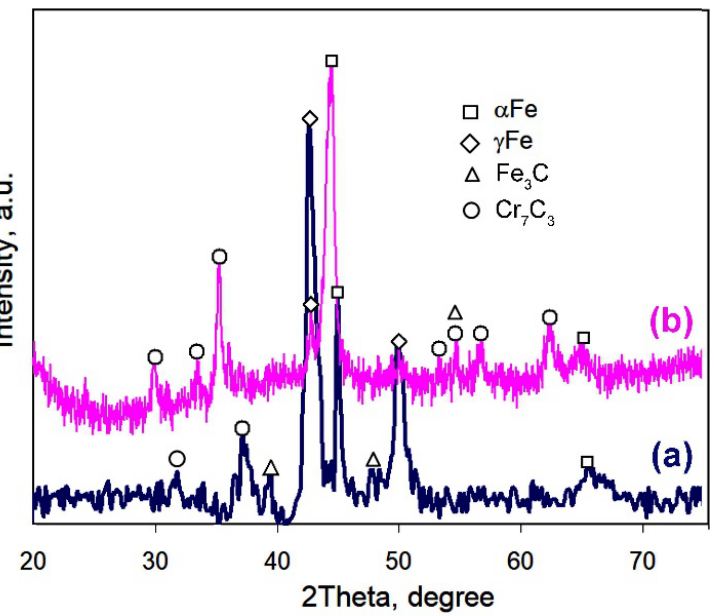
Figure 3. XRD patterns of the coating: ( a ) As-deposited state. ( b ) After post-heat treatment ( α Fe (6– 0696), γFe (4 –0829), (Cr,Fe) 7 C 3 (5–0720), Fe 3 C (35–0772)).